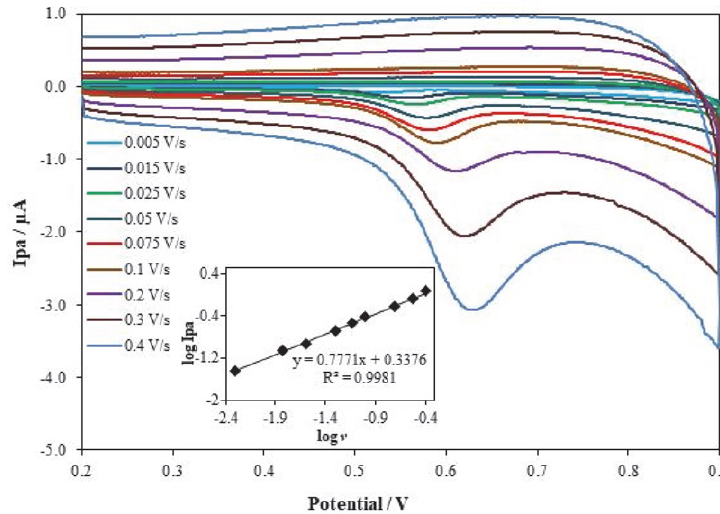
Figure 5. CVs of 1.0 µM KC with increasing scan rates in BR buffer at pH 9.0 . Insets: logυ-logi p